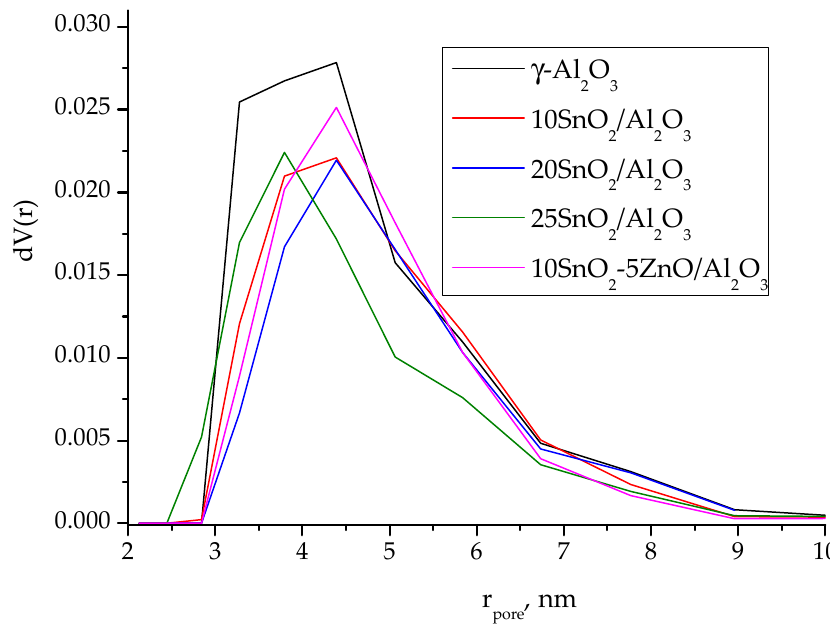
Figure 2. DFT pore-size distributions of samples calcined at 550 °C.